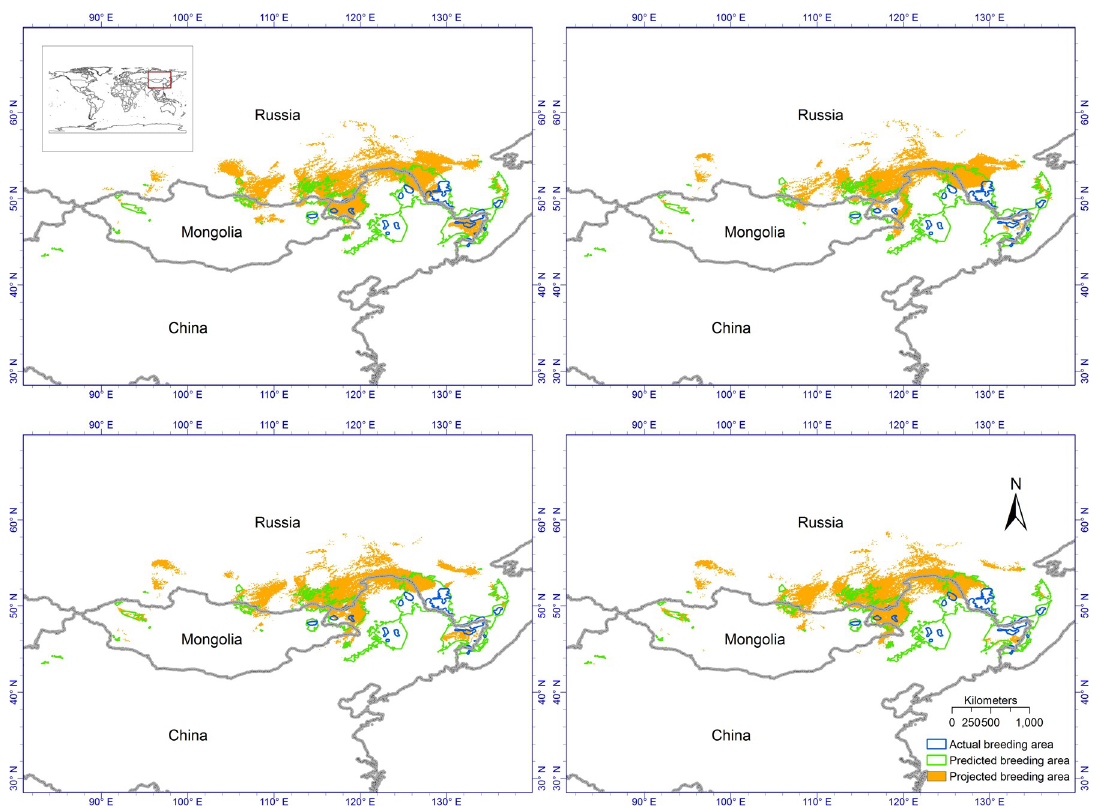
Fig 1. Predicted breeding range of the continental population of the red-crowned crane at 2030s, 2050s, 2070s and 2080s [ 标注到 图上 ]. Blue polygons are the current actual breeding area, green polygons are the predicted potential breeding area under current climate condition, and orange areas are the predicted potential breeding area climate change. Scenario is RCP2.6, low emission